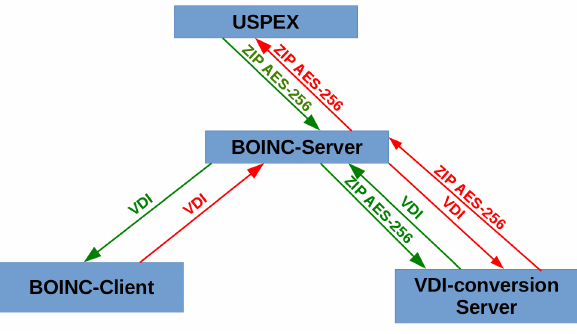
Figure 2: Computational infrastructure and the way of the USPEX